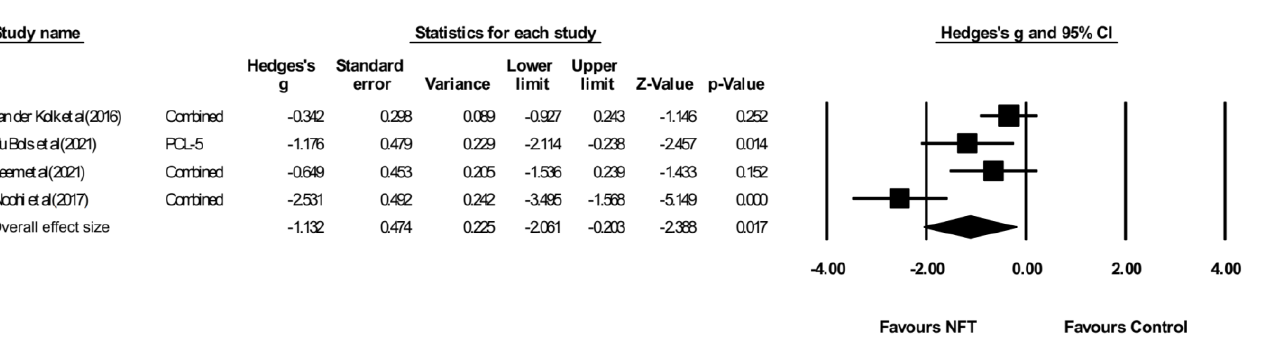
Figure 2. Forest plot of meta-analysis of EEG-NFT on overall PTSD symptoms. vander Kolket et al